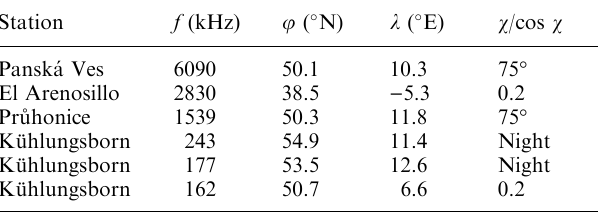
Table 1. Parameters of A3 absorption and IPHA (162 kHz) radio circuits used, name or location of station, frequency, latitude ( u ) and longitude ( k ) of the reflection point (a region of the ionosphere described by the data), the constant solar zenith angle used Station